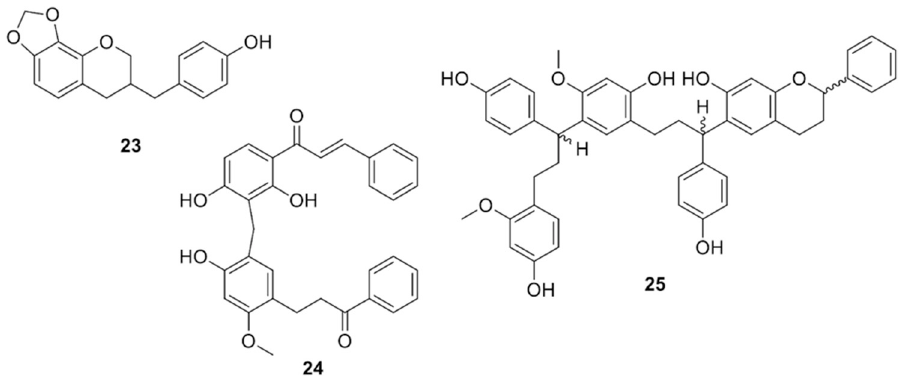
Figure 6. Chemical structures of compounds 23 – 25 isolated from D. cinnabari.